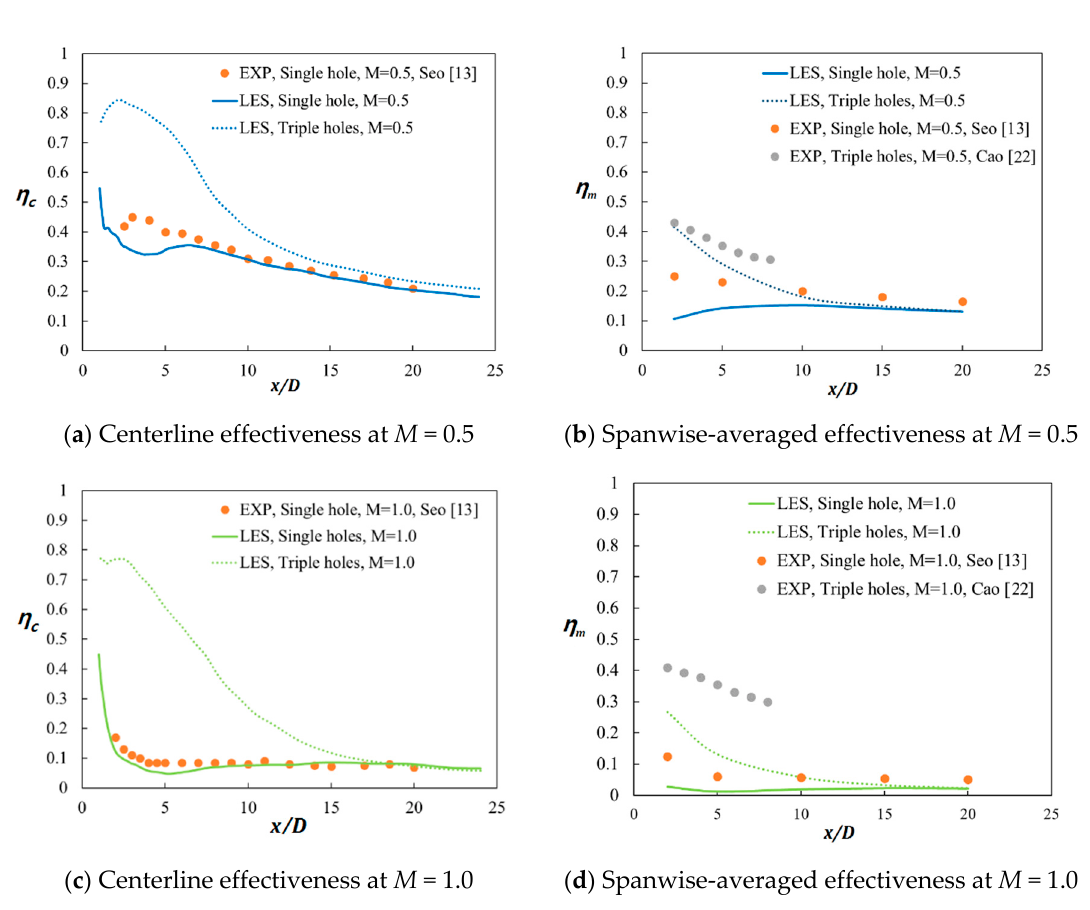
Figure 9. Film cooling effectiveness values of the single- and triple-hole systems.